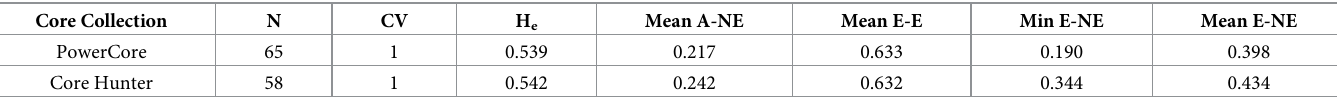
The values in parentheses are percentage of palms per population.